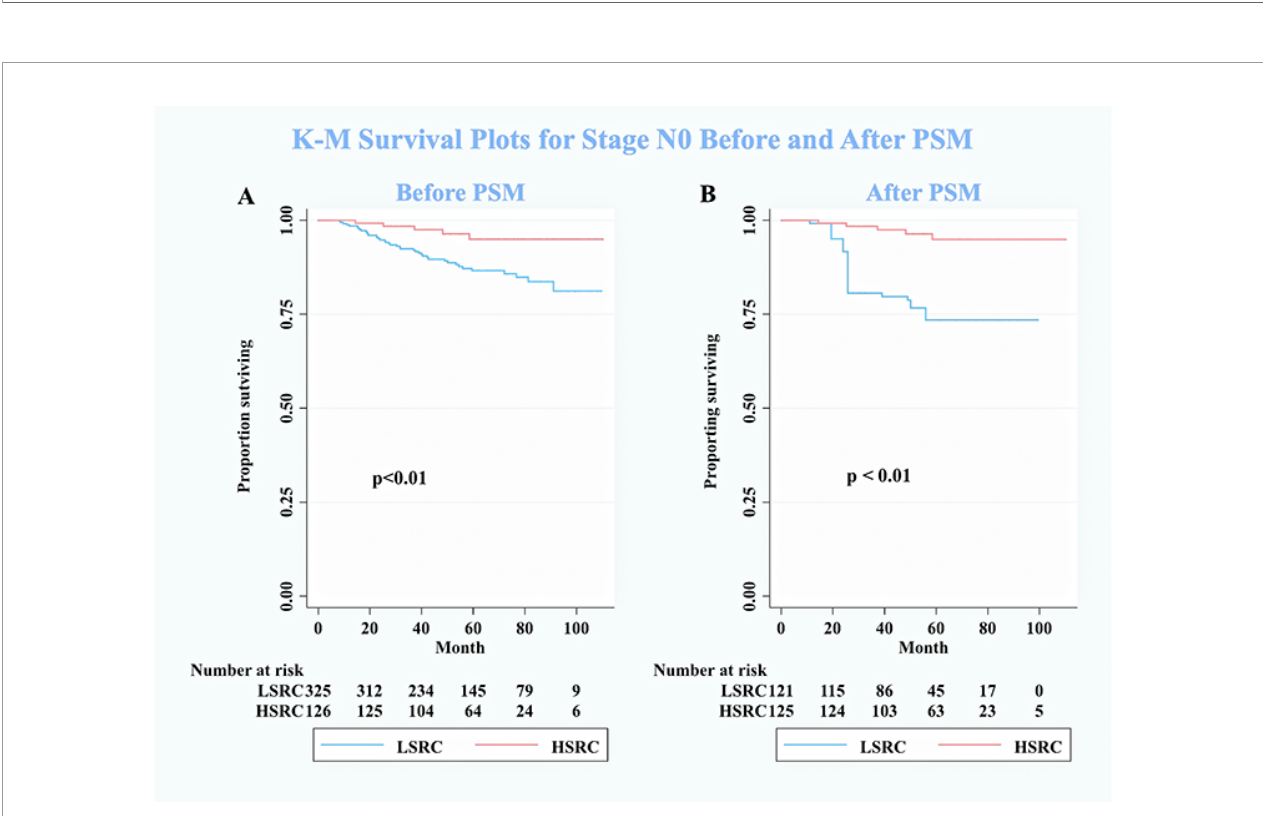
FIGURE 3 | Kaplan – Meier survival curves for patients on stage N0 between low-proportion signet ring cells and high-proportion signet ring cells. (A) Before PSM. (B) After PSM. N0 means no positive lymph nodes. Conversely, N+ means extensive lymphatic involvement, which is a higher pathologic N stage.